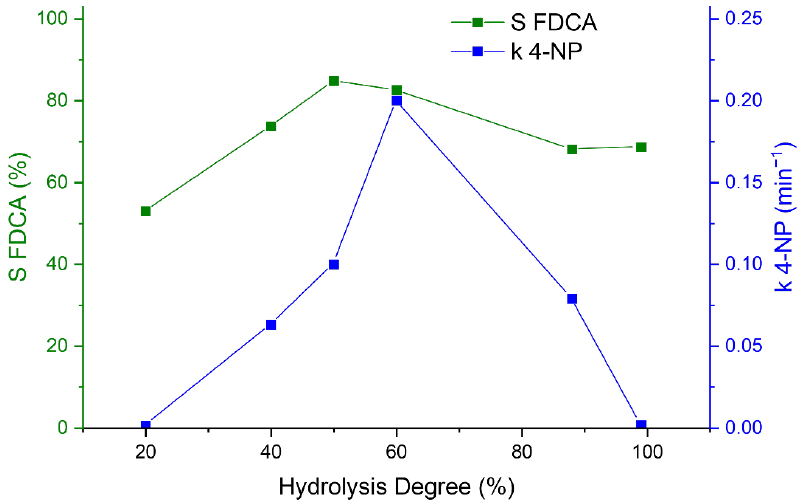
Figure 5. Correlation between FDCA selectivity (S FDCA, in green) and 4-NP reduction pseudo-first-order kinetic constant (k 4-NP, in blue) with changing hydrolysis degree.